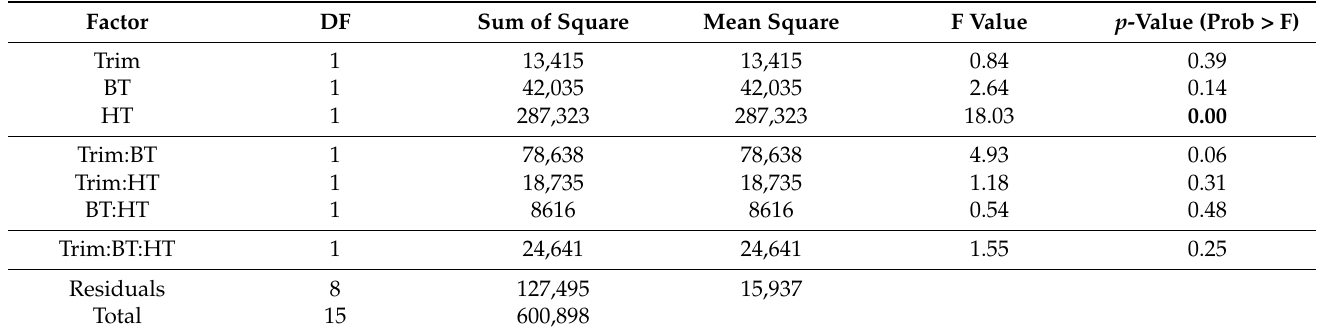
Table 5. Analysis of variances, ANOVA for the G* ( ω = 10 rad/s) at 60 °C for 50/70. Factor DF Sum of Square